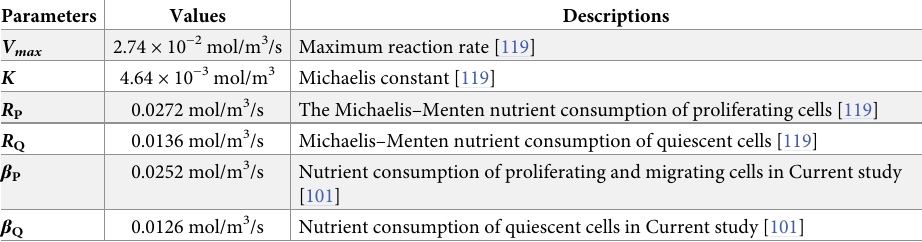
Table 4. Parameters used in the models and corresponding references.